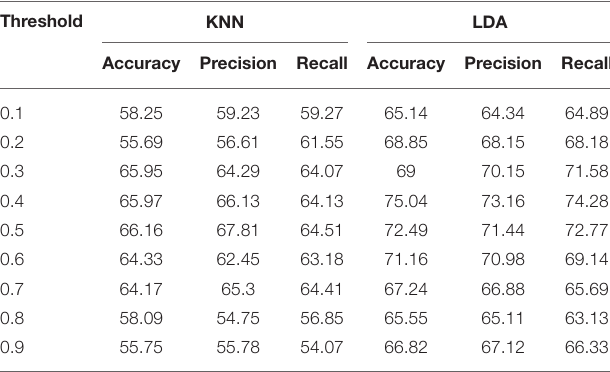
TABLE 7 | Classification performance on the entire validation set by using the five community pattern descriptors as features with KNN and LDA algorithms. Threshold KNN LDA Accuracy Precision Recall Accuracy Precision